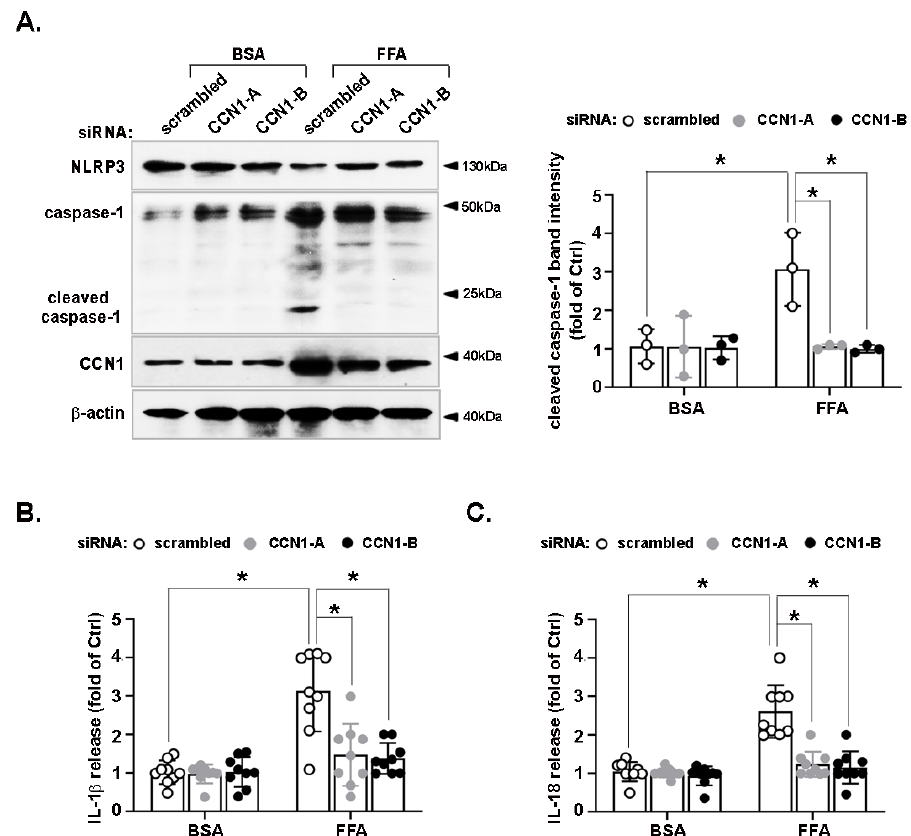
Figure 2. Effects of CCN1 on FFA-activated NLRP3 inflammasome in hepatocytes. LO2 hepatocytes were transfected with scrambled siRNA or two pairs of CCN1 siRNAs (CCN1-A and CCN1-B), then incubated with FFA (1 mM) for 24 h and ATP (5 mM for 30 min before harvest). Protein levels of NLRP3, caspase-1, CCN1, and β -actin in the cell lysates were analyzed by immunoblotting ( A ). Immunoblots shown are representative of three independent experiments. Quantifications of band intensity were normalized to β -actin. The concentrations of IL-1 β ( B ) and IL-18 ( C ) in the conditioned medium were determined by ELISA. The ELISA data shown are from three independent experiments performed in triplicate. * p < 0.05.